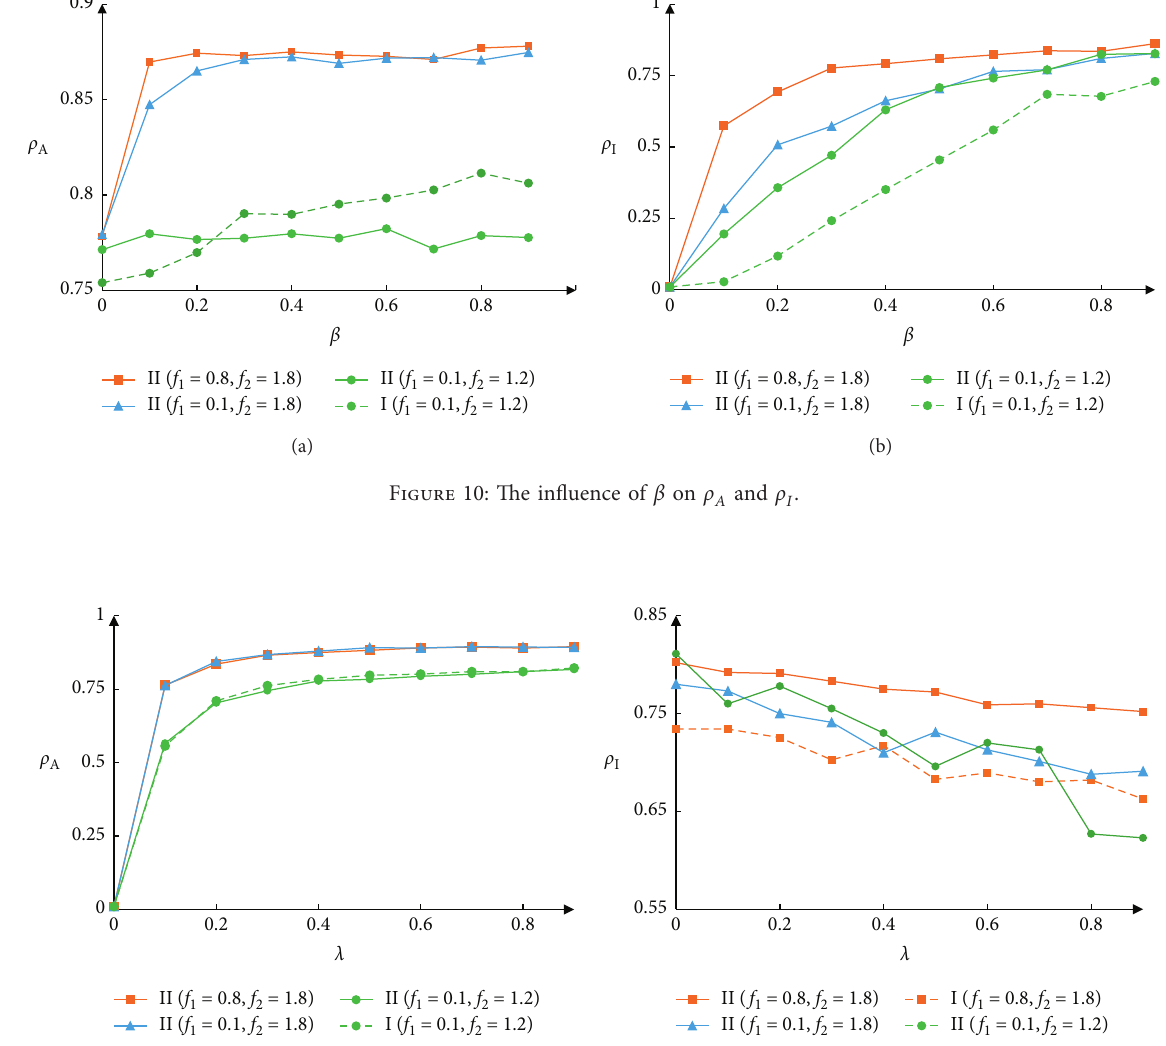
Figure 11: The influence of λ on ρ